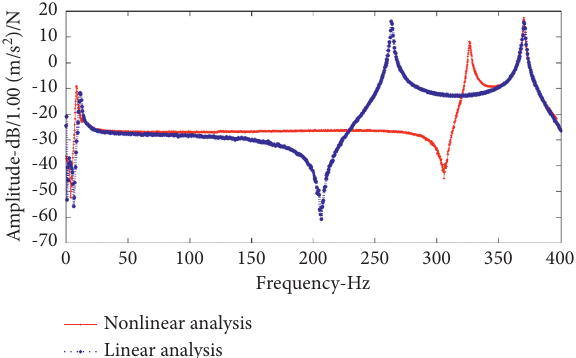
Figure 12: The comparison of linear and nonlinear analysis (random excitation force is 10.8N).